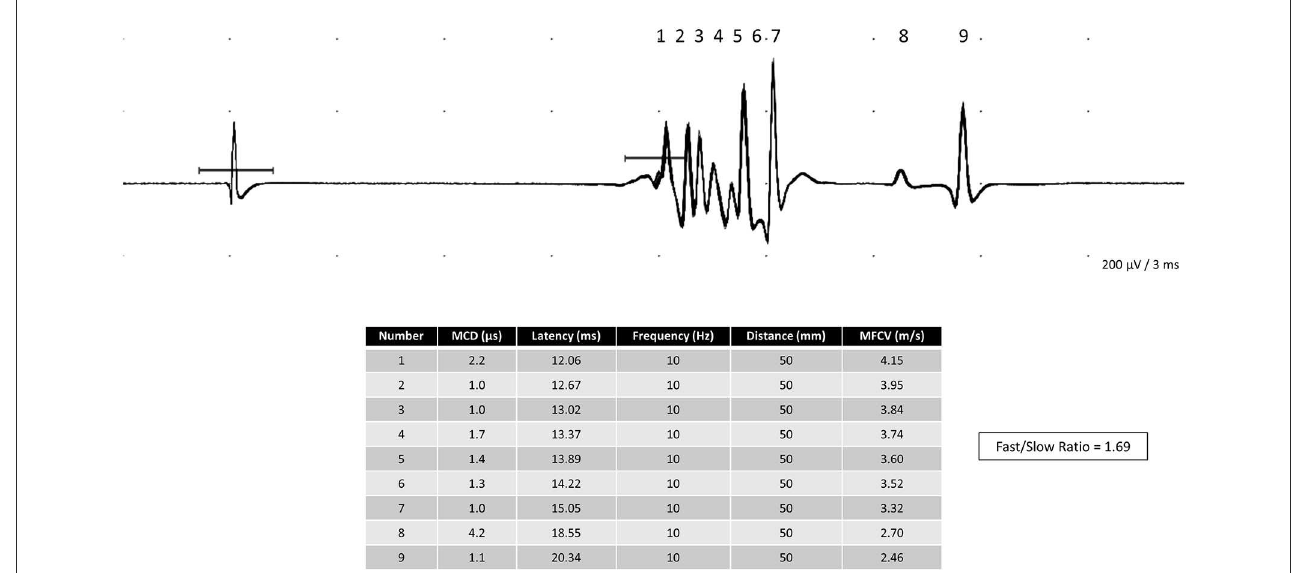
FIGURE1 Polyphasic complex of nine single muscle fiber action potentials in the tibialis anterior was obtained after the electrical stimulation of an intramuscular monopolar needle. The fast-to-slow muscle fiber conduction (F/S ratio) calculated in this complex is 1.69.